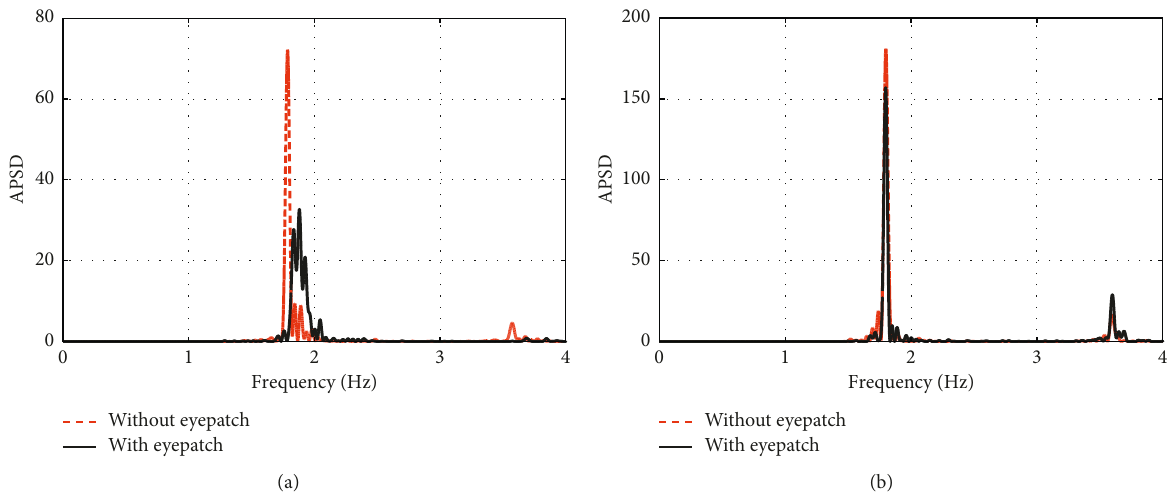
Figure 32: PSDs of the clavicle acceleration of (a) Participant No. 32 and (b) Participant No. 13 bouncing with and without an eyepatch for the 1 × 1 m configuration at 1.8Hz.